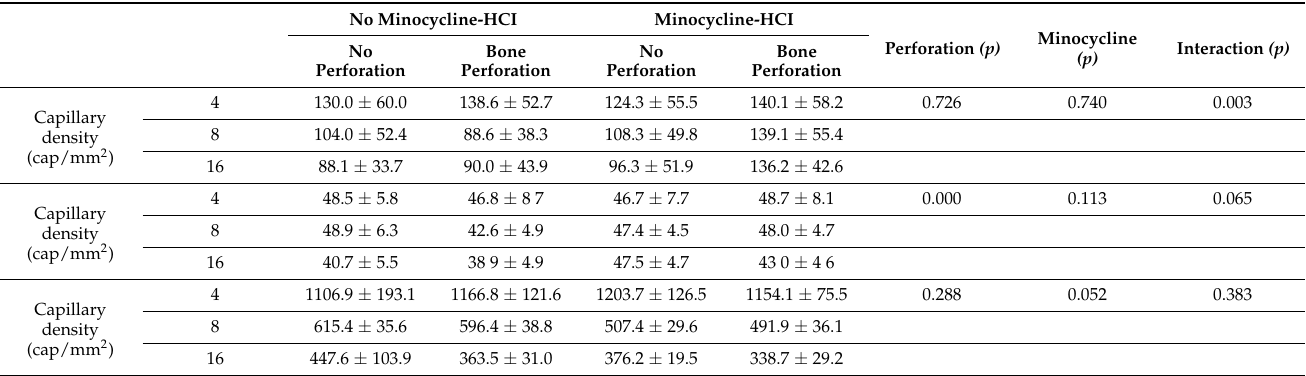
Table 1. Capillary, Osteoblast and Osteocyte Histomorphometric Data for Minocycline-HCI and No Minocycline-HCI treated Perforated and Non Perforated Rats.